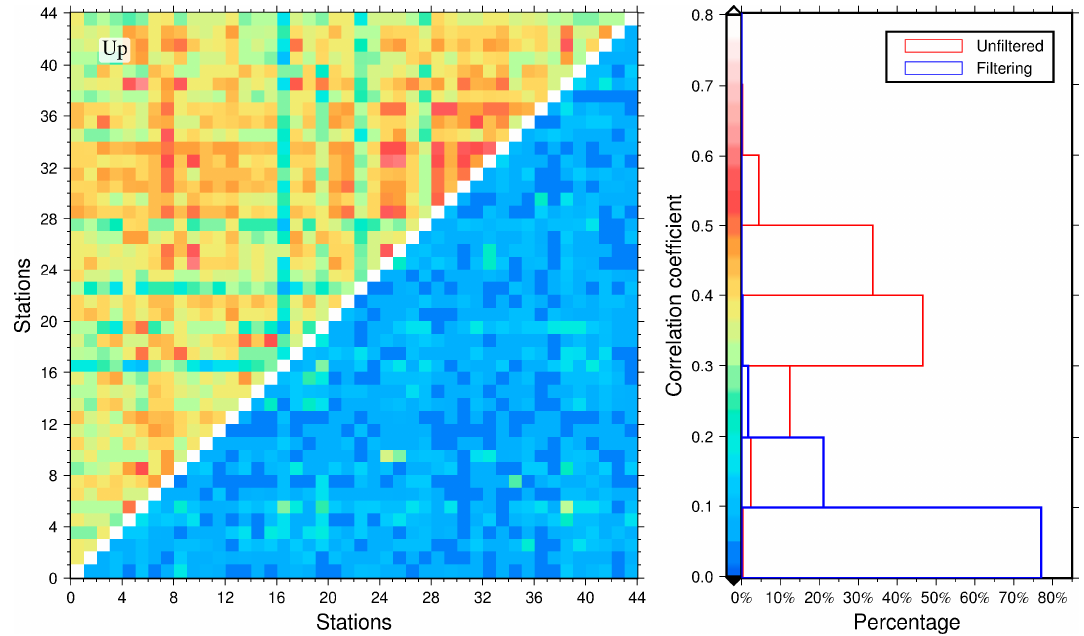
Figure 6. Interstation correlation coefficients (left panels) and the histograms (right panels) before and after filtering CME from residual time series for the north (top panels), east (middle panels), and up (bottom panels) components. The unfiltered and filtered interstation correlation coefficients are separately shown at the upper triangle and lower triangular of the left panels, while their corresponding histograms are shown as red and blue colors in the right panels, respectively.